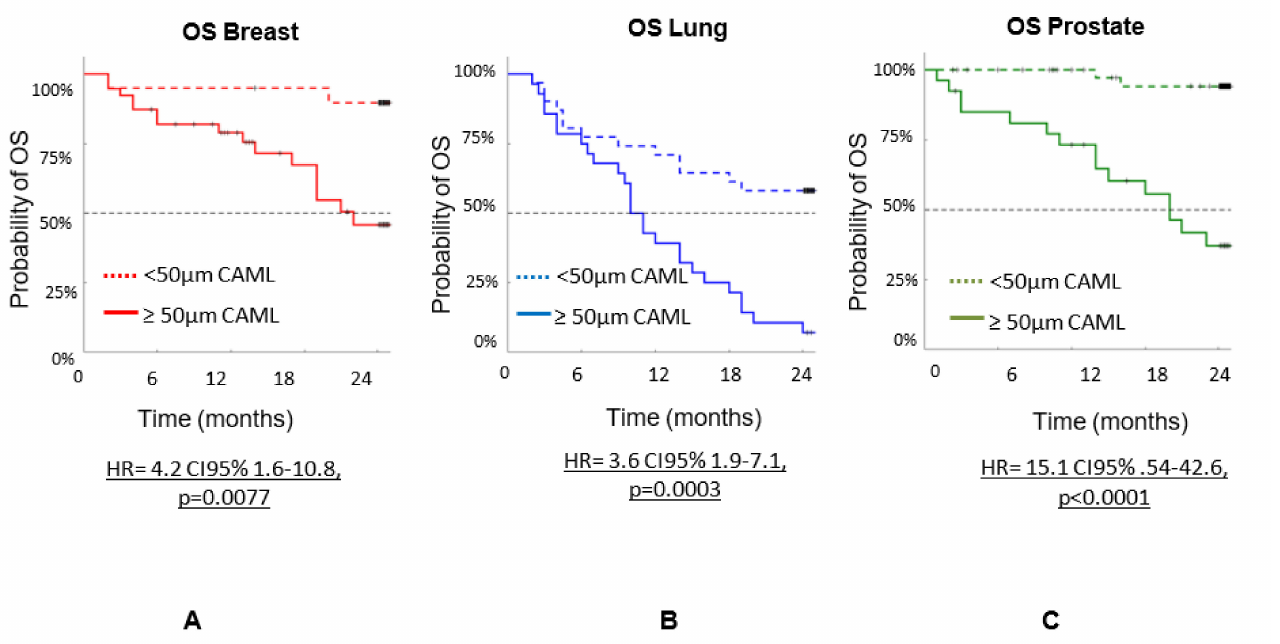
Figure 4. OS of n = 192 patients with three types of cancers (breast, prostate and lung). OS based on CAML size determined during a 24-month follow-up. ( A ) is OS for breast cancer patients. ( B ) is OS for lung cancer patients and ( C ) is OS for prostate cancer patients. The data shows that patients with CAMLs ≥ 50 µ m all has shorter OS than patients with CAML < 50 µ m independent of type of